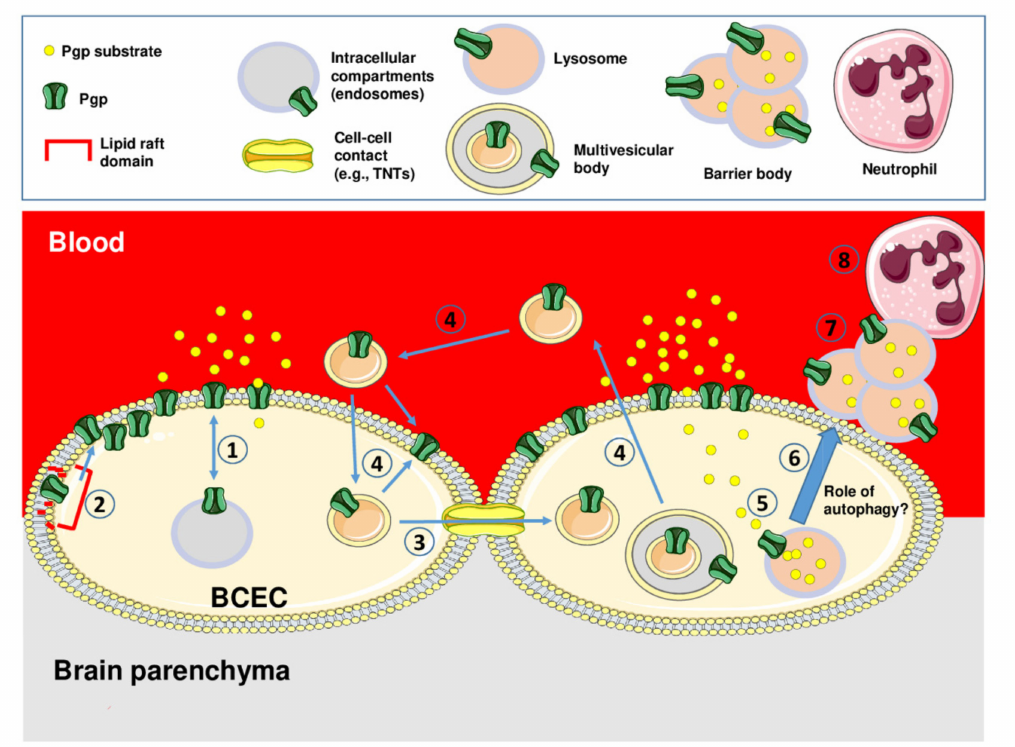
Figure 3. Schematic illustration of intra- and intercellular tra ffi cking of Pgp and Pgp-mediated lysosomal drug sequestration and disposal in brain capillary endothelial cells that form the BBB. Intracellular tra ffi cking of Pgp from intracellular endosomal compartments to the apical membrane is illustrated by (1), while the tra ffi cking of Pgp within the membrane from lipid raft regions to non-lipid raft regions is illustrated by (2). Intercellular Pgp tra ffi cking may occur via cell-to-cell contacts, e.g., tunneling nanotubes as indicated by (3), or via the transfer of Pgp-containing extracellular vesicles (e.g., exosomes released from multivesicular bodies [MVBs]) as indicated by (4). The intracellular Pgp-mediated sequestration of Pgp substrates in lysosomes is illustrated by (5). Subsequently, lysosomes containing the Pgp substrate leave the cell, e.g., by fusing with autophagosomes to autolysosomes (6), and form aciniform apical aggregates (“barrier bodies”; (7)) that are phagocytized by neutrophil granulocytes (8). Note that the di ff erent cell and vesicle types are not drawn to scale. See text for